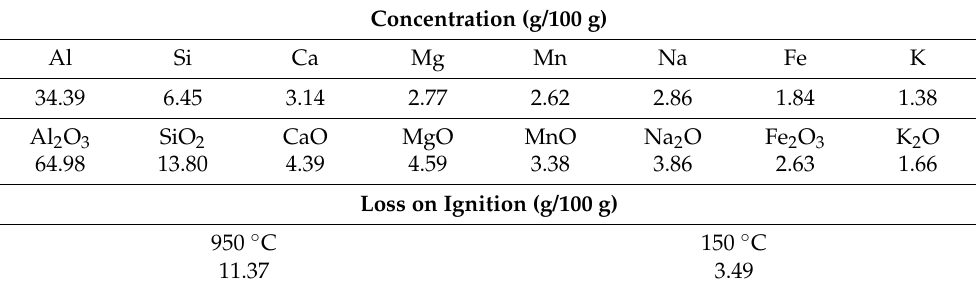
Table 3. Major components of alumina